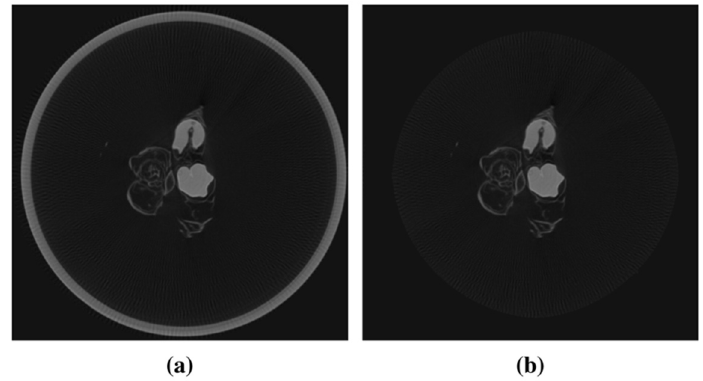
Figure 6. Holder clearance processing. ( a ) The raw image; ( b ) Image after removing holder using Region of Interest (ROI).